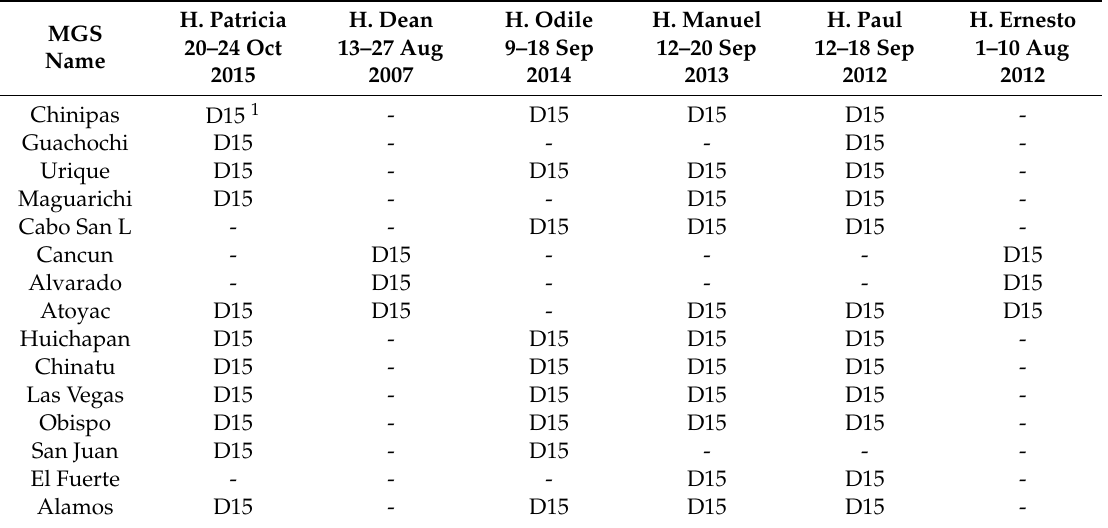
Table 1. Relation of automatic rain-gauge stations (MGS) and the hurricanes